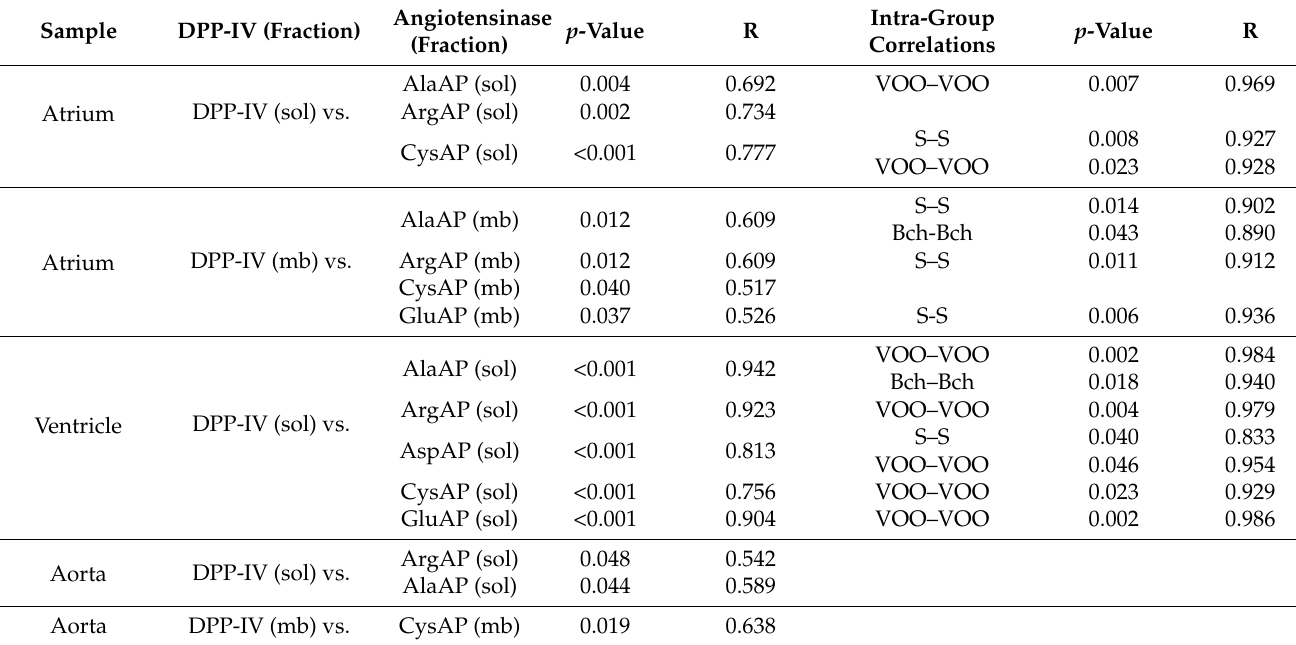
Table 1. Significant correlations of dipeptidyl peptidase IV (DPP-IV) activity with angiotensinase activities in atrium, ventricle, and aorta.